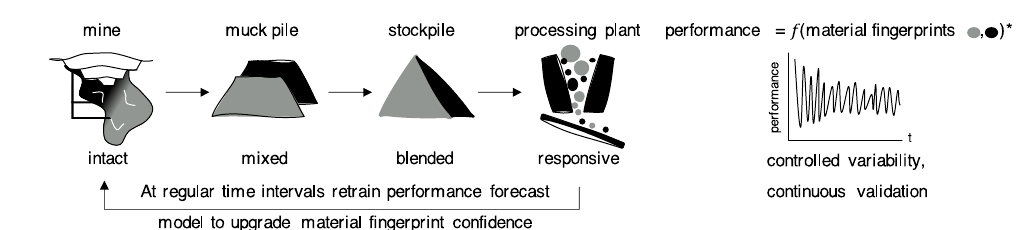
Figure 1. Concept of material fingerprints. Material attribute classes (fingerprints) can be tracked through the unit operations of a mining cycle and indicate the performance of processing them. Regular revision of the material fingerprint confidence over time (feedback loop) allows for controlling the performance variability and continuous validation. * Neglecting the changing process unit operating conditions.